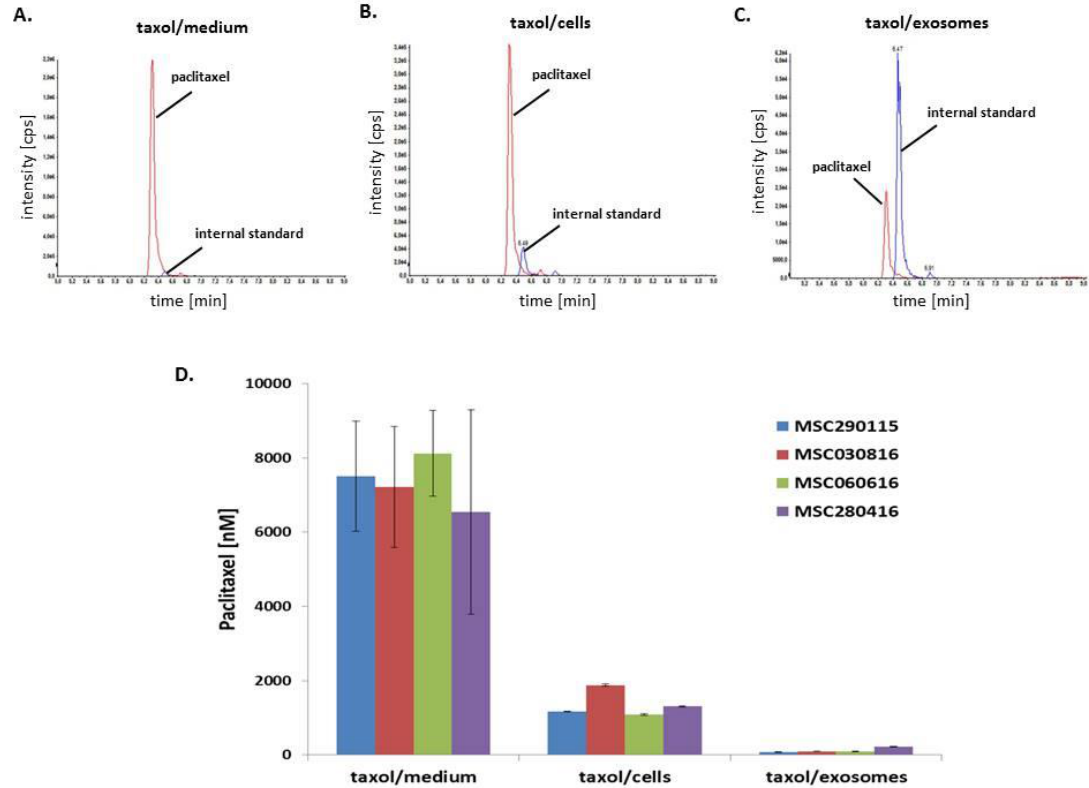
Figure 3. Representative MSC290115 GFP LC-MS / MS-chromatograms of paclitaxel (m / z: 854 → 105,